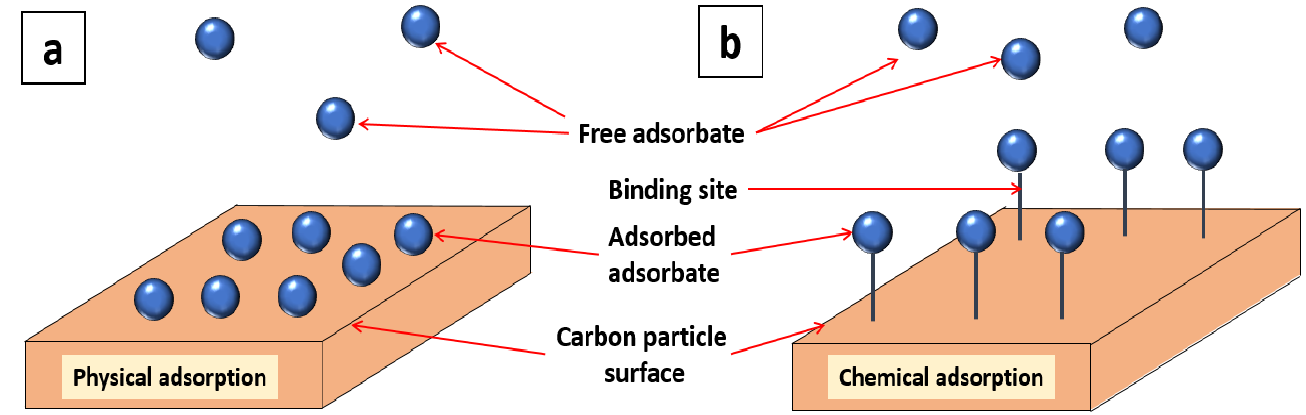
Fig. 2. Illustration adsorbent surface-adsorbent interaction mechanism in physisorption (a) and chemisorption (b)